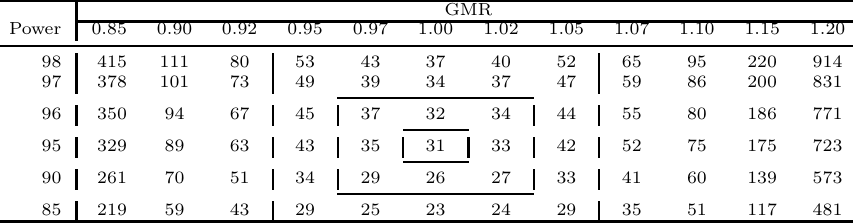
Sample size variations for different Power and GMR